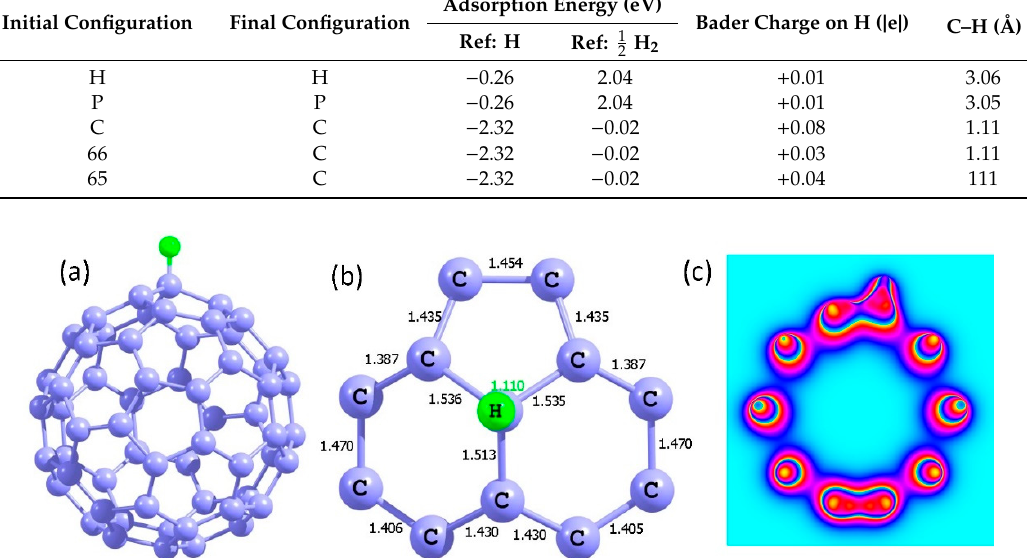
Table 2. Initial and final configurations of a single H atom adsorbed on the surface of pristine C 60 , adsorption energies calculated with respect to gas phase hydrogen atom and diatomic molecule as reference states, Bader charges on the H atoms and shortest C–H bond in the optimized configurations.